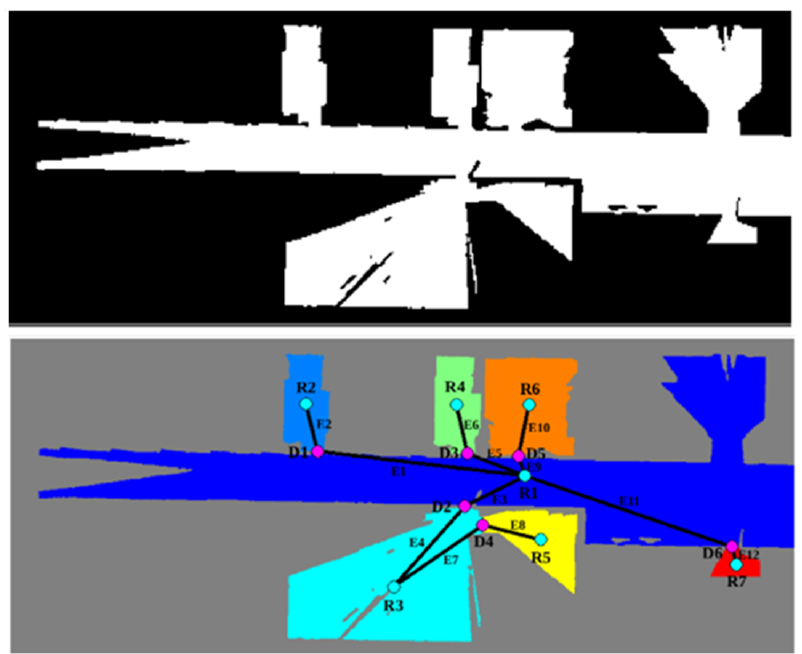
Figure 6. Segmented occupancy grid map and topological map extraction. Each node and edge is labeled with a different number, where R corresponds to room nodes, D corresponds to door nodes and E represent edges.